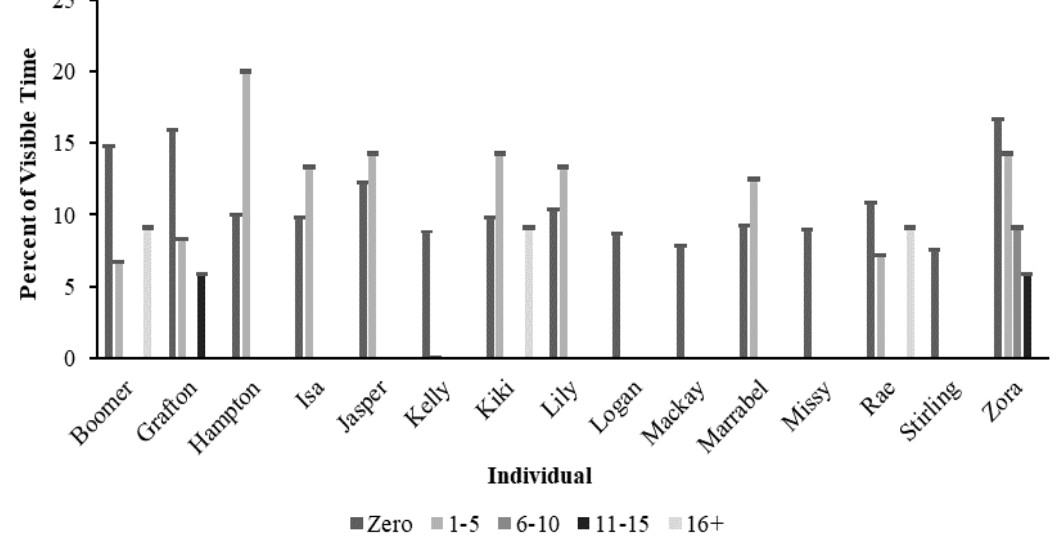
Percent ± SE of Visible Time Individuals Spent Feeding Across Crowd Size